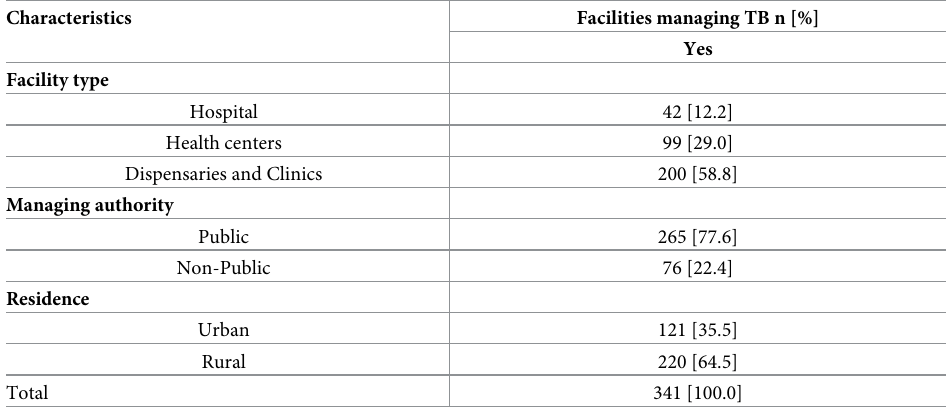
Table 1. Distribution characteristics of facilities reported to provide tuberculosis services [N = 341].